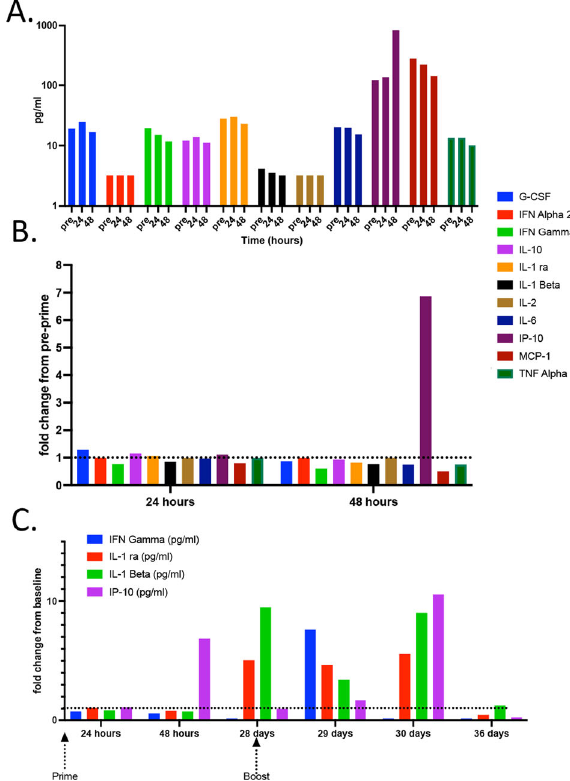
Fig. 1 Innate cytokines in response to primary and secondary mRNA-1273 vaccination. Innate cytokine levels were evaluated by Luminex in the serum samples obtained at the time points indicated. A Total cytokine amounts before initial vaccination (pre) and at 24 and 48 h post the fi rst injection. B All cytokine levels normalized to pre-vaccination levels and expressed as fold change. C Similarly normalized data covering both primary and secondary injections. Only the cytokines with a demonstrable fold change from baseline (pre-primary vaccination) are